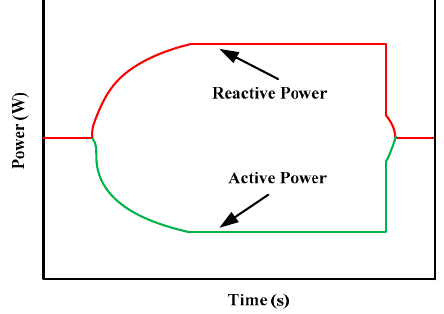
Figure 19. Reactive power support diagram.